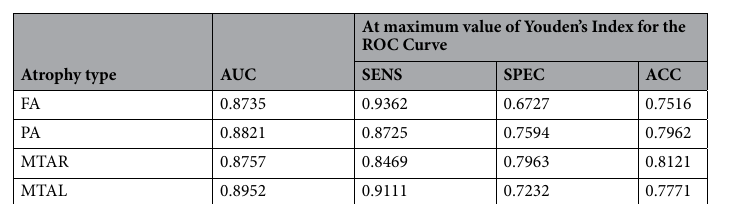
Table 2. Binary classification result of atrophy rating through regularized logistic regression. FA frontal atrophy, PA Parietal atrophy, MTAR medial temporal atrophy, right, MTAL medial temporal atrophy, left.